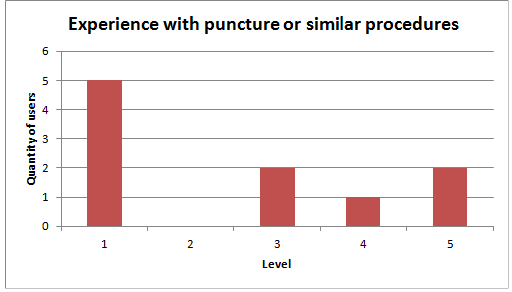
Figure 16. ViMeTGame Evaluation question about the level of knowledge in puncture procedures or similar procedures. Scale: 1 to “None”and 5 to